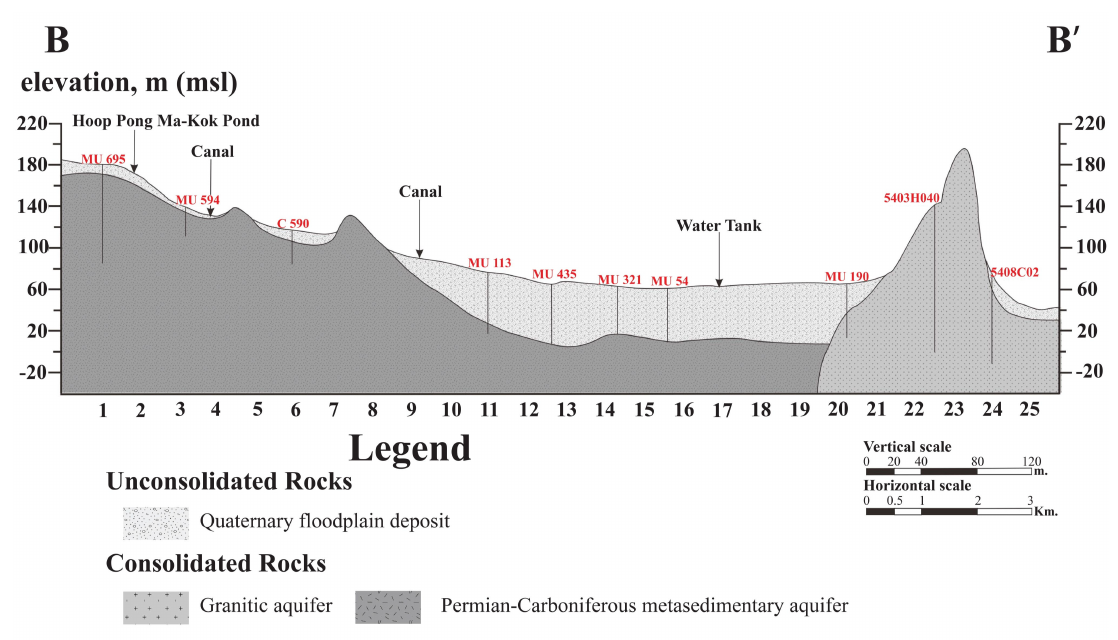
Figure 2. Hydrogeologic cross-section of section A-A’ (modified from [18]).